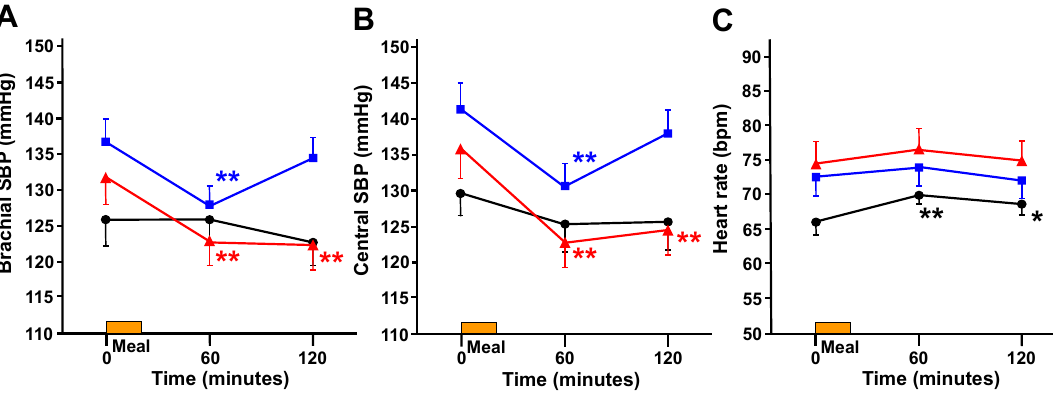
Figure 4. Changes in brachial systolic blood pressure (SBP) ( A ), central SBP ( B ), and heart rate ( C ) during the meal tolerance test. The control group is indicated by the black line and circles (●); the mild group by the blue line and squares ( ■ ); and the severe group by the red line and triangles ( ▲ ). ** p < 0.01, * p < 0.05 vs. 0 min.